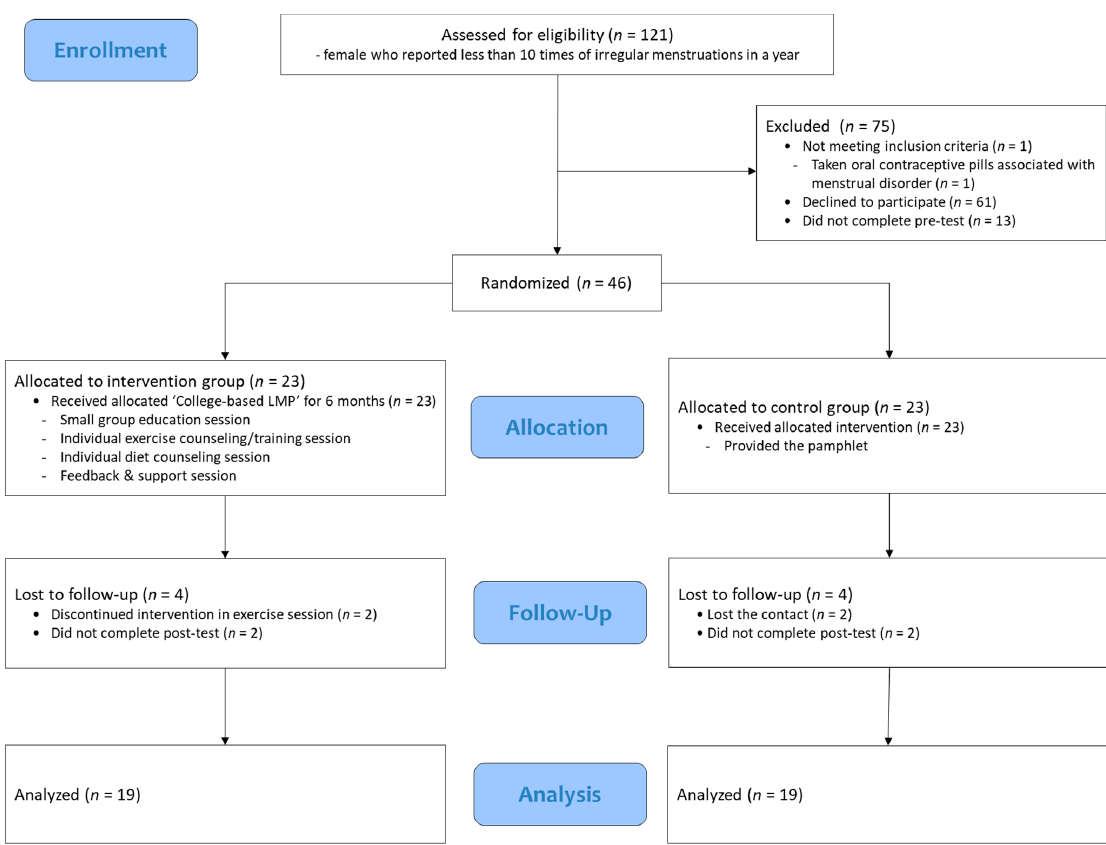
Figure 1. Participant flow diagram .Note. College-based LMP = College-based Lifestyle Modification Program.